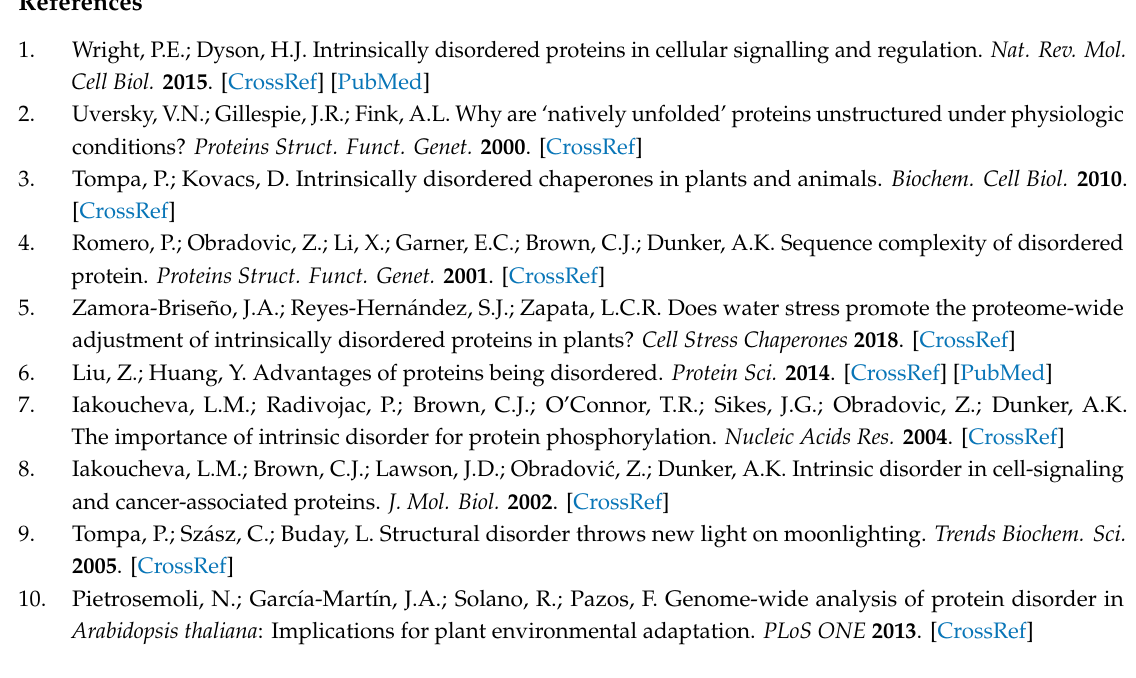
Table S1: Expression profile of transcripts encoding structured proteins ( < 25% of protein disorder) during seed development, and their prediction of disorder content, Table S2: Expression profile of transcripts encoding intrinsically disordered proteins (25–50% of protein disorder) during seed development, and their prediction of disorder content, Table S3: Expression profile of transcripts encoding intrinsically disordered proteins (50–75% of protein disorder) during seed development, and their prediction of disorder content, Table S4: Expression profile of transcripts encoding highly disordered proteins ( > 75% of protein disorder) during seed development, and their prediction of disorder content, Table S5: Complete list of up-regulated transcripts encoding highly intrinsically disordered proteins ( > 75% of protein disorder) during seed development, Table S6: Complete list of down-regulated transcripts encoding highly intrinsically disordered proteins ( > 75% of protein disorder) during seed development, Table S7: Complete list of up-regulated key TFs, their target genes and their disorder category that they belong